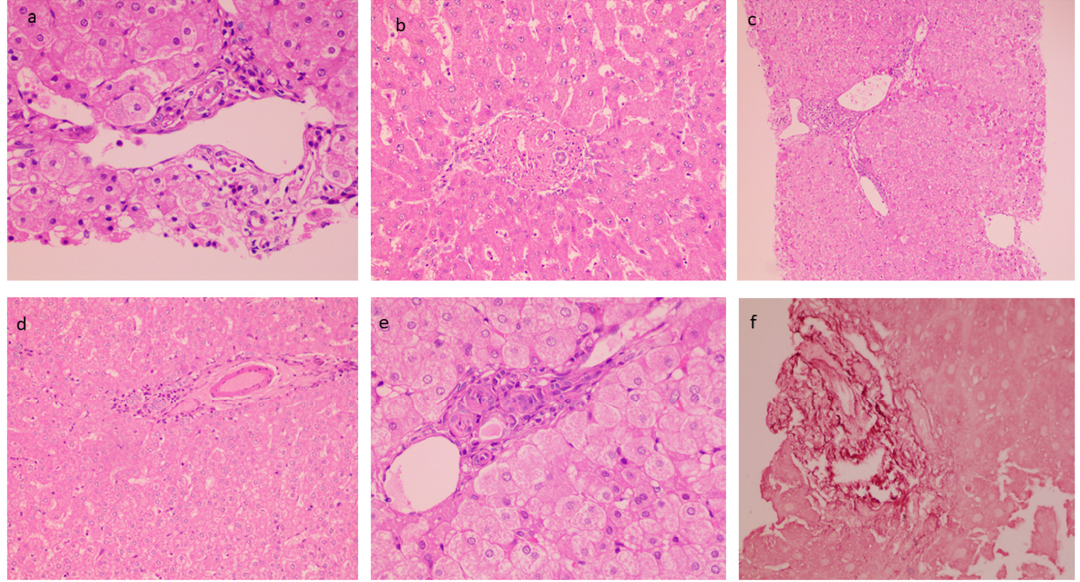
Figure 2. Histological characteristics of EHPVO: ( a ) Minimal Portal Inflammation (20×, HE); ( b ) por ‐ tal sclerosis (20×, HE); ( c ) dilated multiple portal venous channels (20×, HE); ( d ) hepatic artery thick ‐ ening (10×, HE); ( e ) presence of aberrant vascular channels around portal tracts (20×, HE); and ( f ) elastosis of portal veins (20×, orcein).